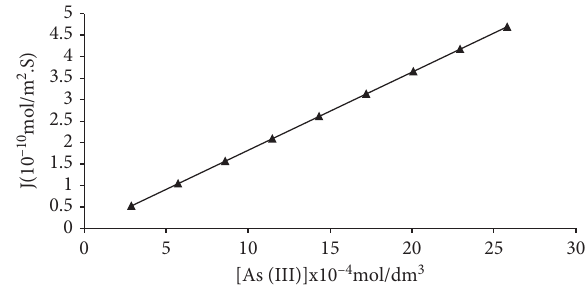
Figure 7: Effect of metal ion concentration on transport of As (III). [HCl] in feed solution � 0.75mol/dm 3 , [TDDA] in membrane phase � 0.63mol/dm 3 , [NaOH] in stripping solution � 1.05mol/ dm 3 , [As (III)] � 2.867 × 10 − 4 mol/dm 3 to 25.8 × 10 − 4 mol/dm 3 , [H 2 O 2 ] � 10 − 7 mol/L, time �